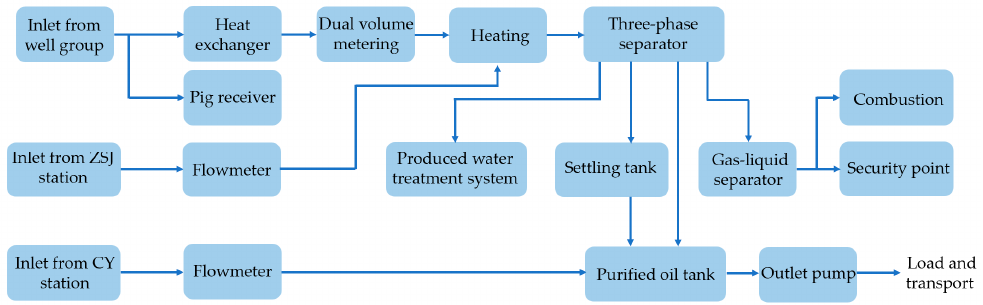
Figure 4. Process flow diagram of Laozhuang union station.